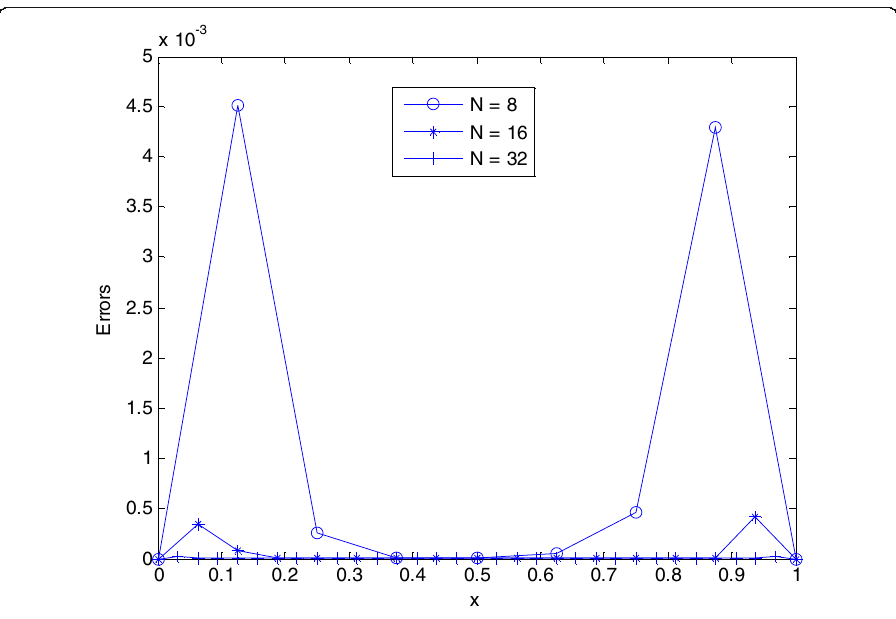
Fig. 3 Point-wise absolute errors of Example 1 at ε = 2 − 12 with different mesh size h